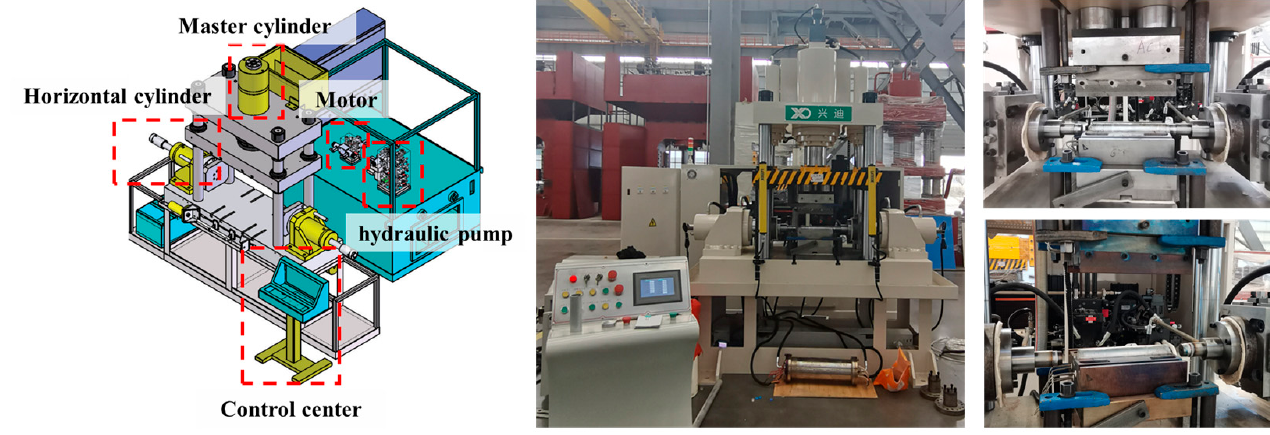
Figure 5. The equipment of HMGF.